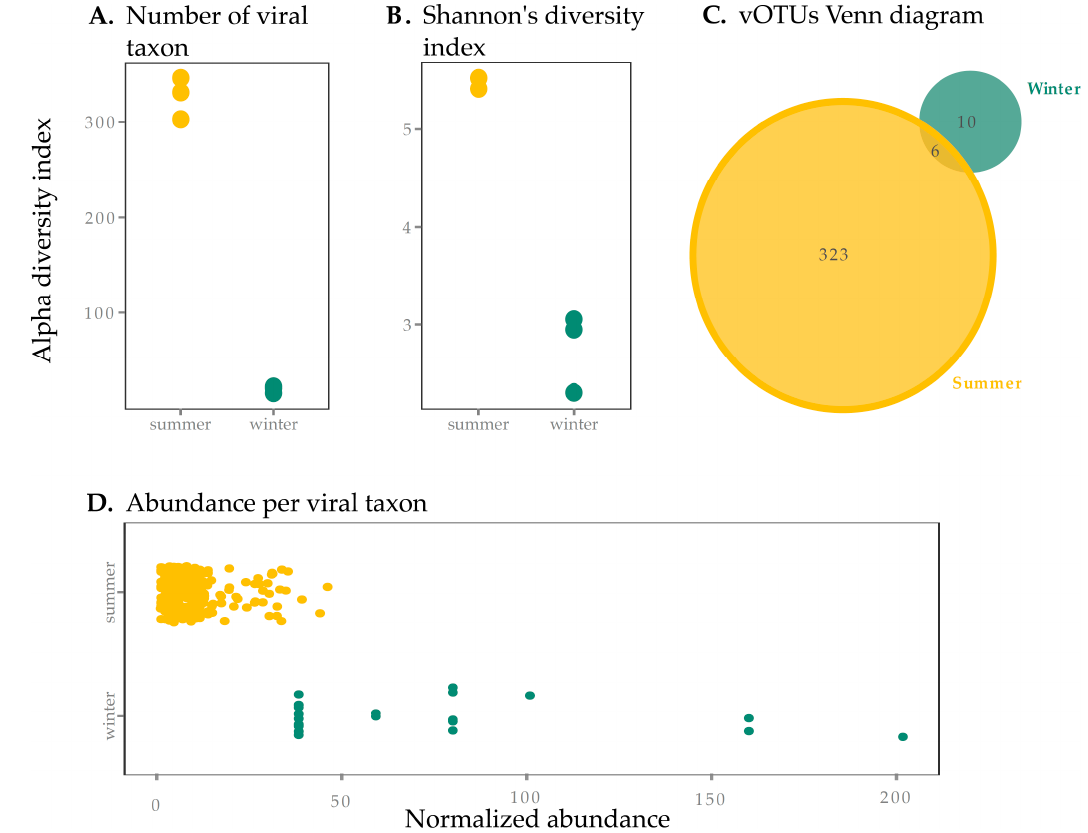
Figure 1. Viral sample richness (within sample diversity) and taxa abundance in summer and winter surface samples from SAS2A. Diversity results are presented using the ( A ) number of viral taxa present (presence of a viral operational taxonomic unit (vOTU)) and ( B ) the Shannon diversity index (to account for evenness). Summer samples had significantly higher diversity in terms of the number of viral taxa ( A ) but the difference between seasons was not significantly different for the Shannon Index ( B ) ( p > 0.05). ( C ) We also present a Venn diagram for vOTUs found in summer and winter, showing there is little overlap between seasons (6 vOTUs, 1.7%). ( D ) Abundance per viral taxon is greater in the winter, with a few taxa dominating the community, supporting observations from Shannon’s diversity index ( B ).